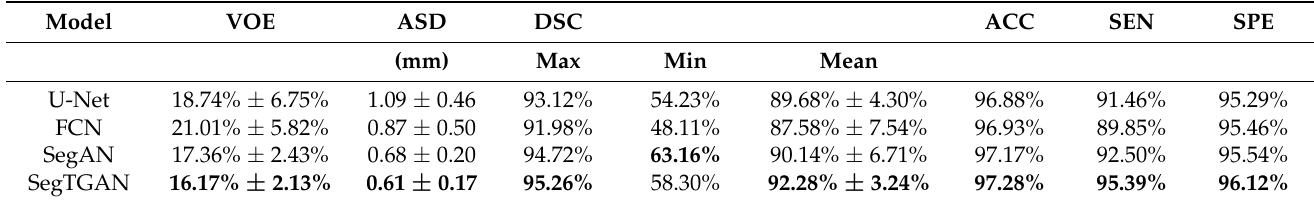
Table 2. Comparison of U-Net, FCN, SegAN, and SegTGAN on the Kits19 dataset.